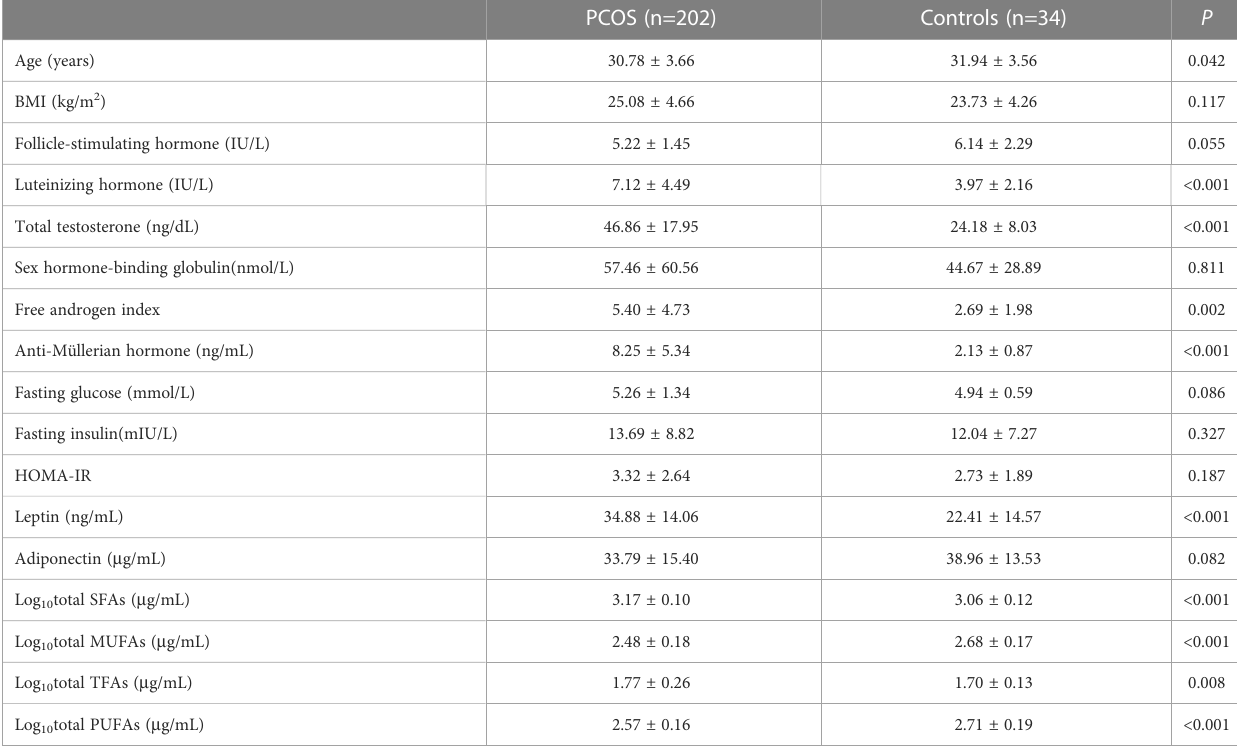
TABLE 1 Characteristics of PCOS cases and